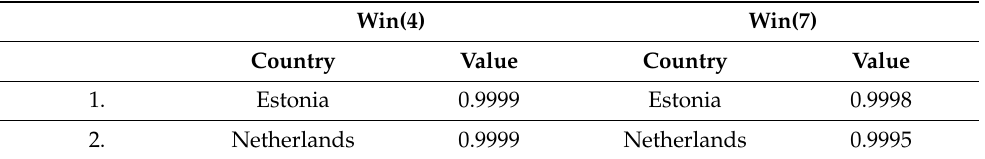
Table A2. Window analysis results with different window width for the reference period